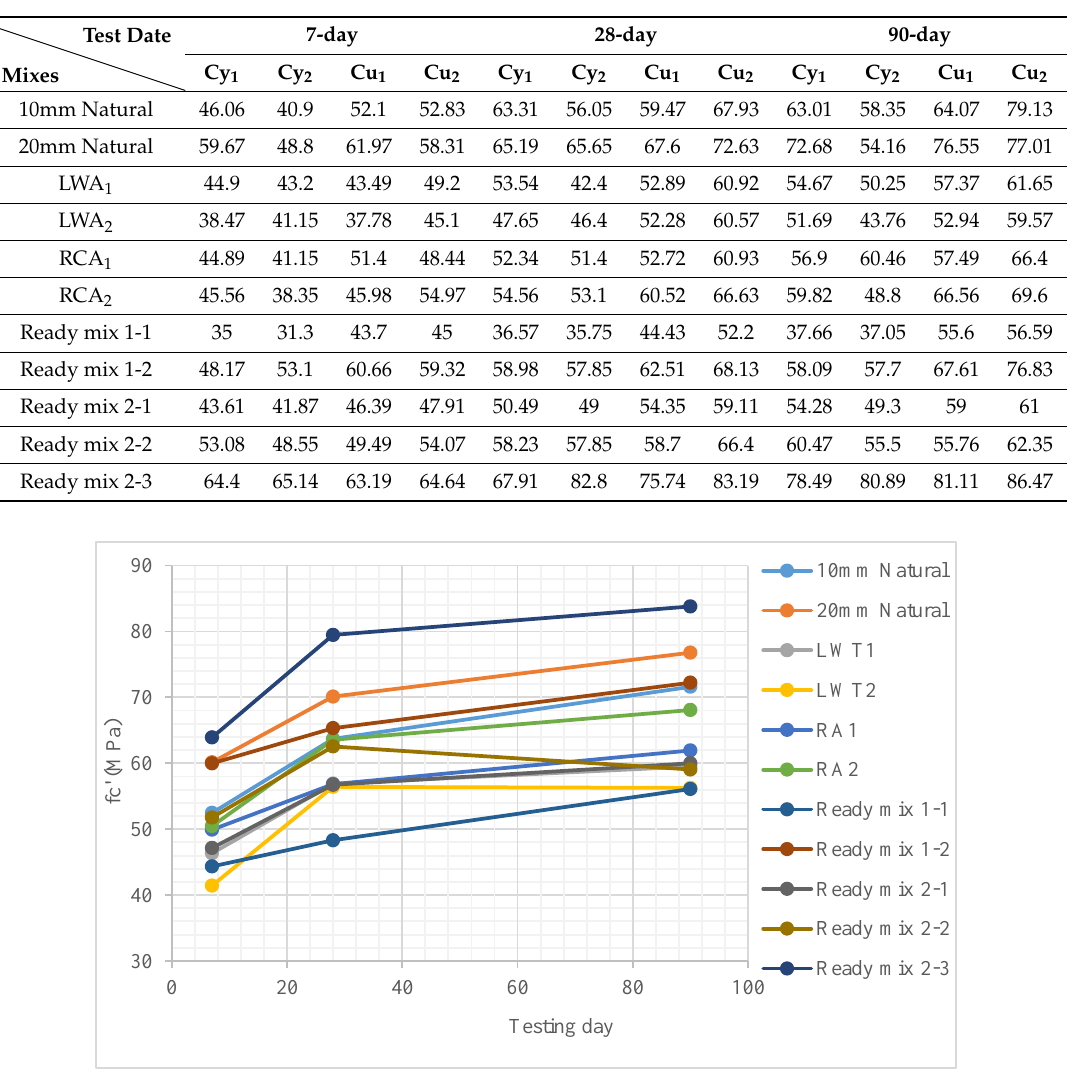
Table 7. Summary of compressive strength for different concrete mixes at 7th, 28th, and 90th day.